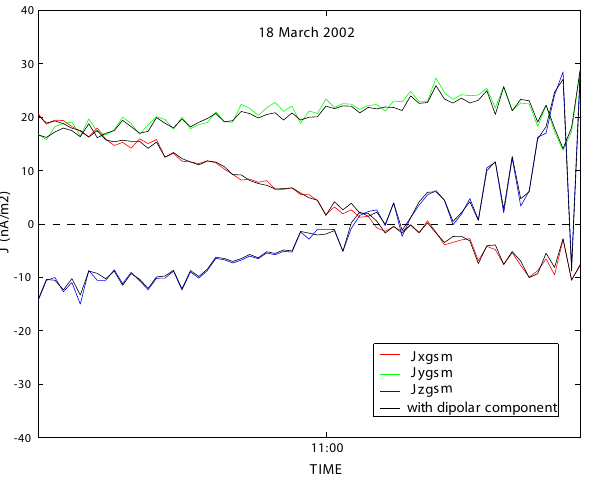
Figure 5 Fig. 5. Current density (in the GSE coordinate system) as computed Figure 3 Fig. 3. Current density (in the the GSM coordinate system) as com- using two different magnetic field data inputs: FGM data (colored puted using two different magnetic field data inputs: FGM data curves) and FGM data to which we added an artificial gain of 0.1% (black curves) and FGM data from which we subtracted the dipolar on the B z component (on SC1, black dashed field contribution (colored curves).